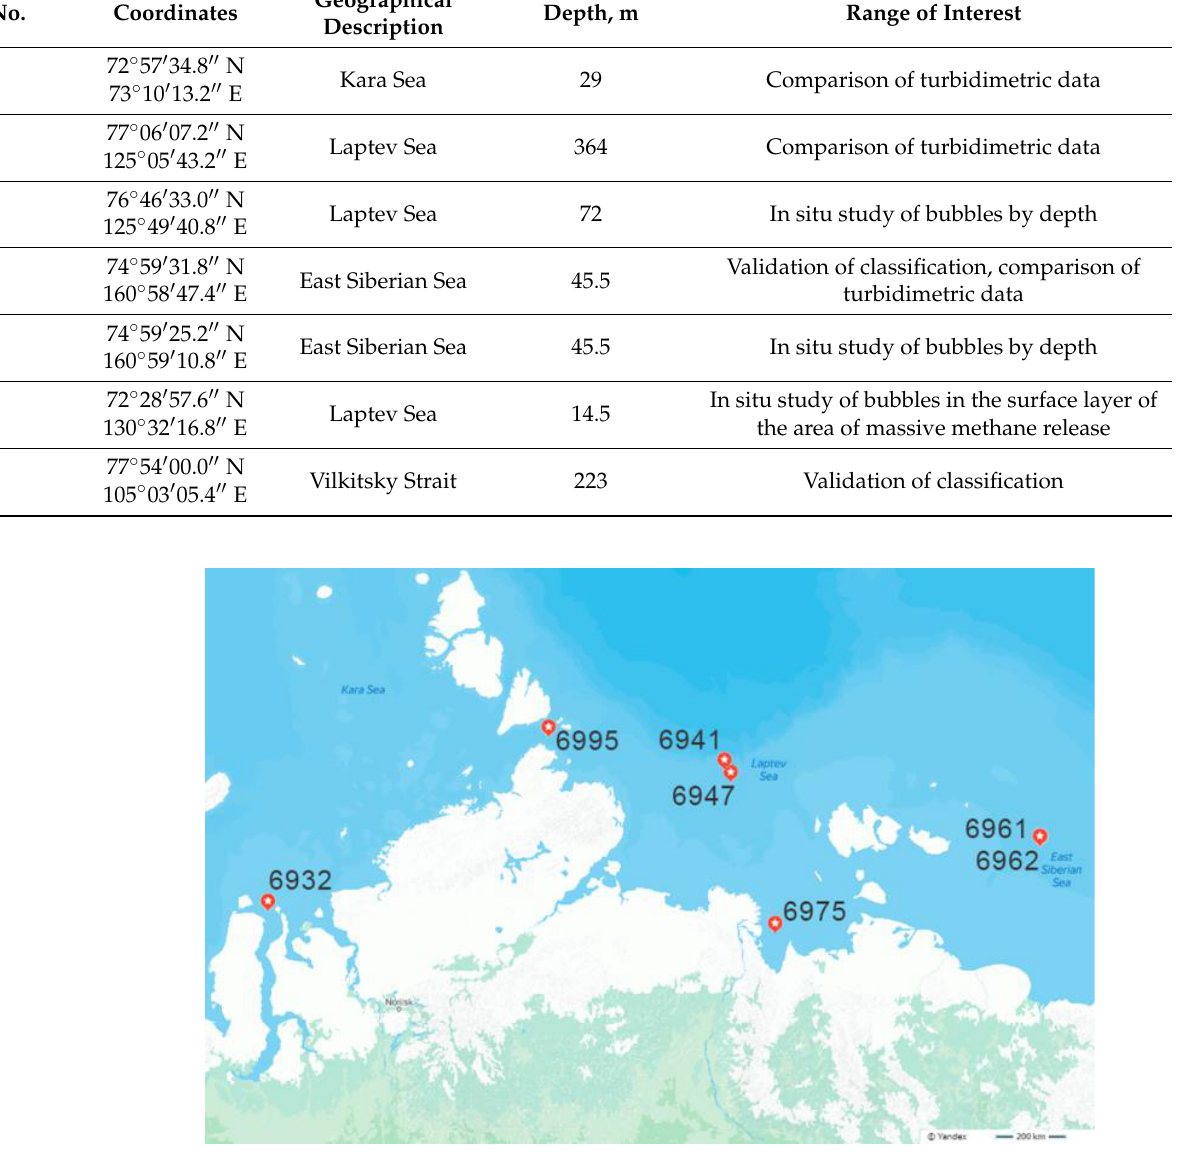
Figure 10. Map of the studied AMK-82 stations.